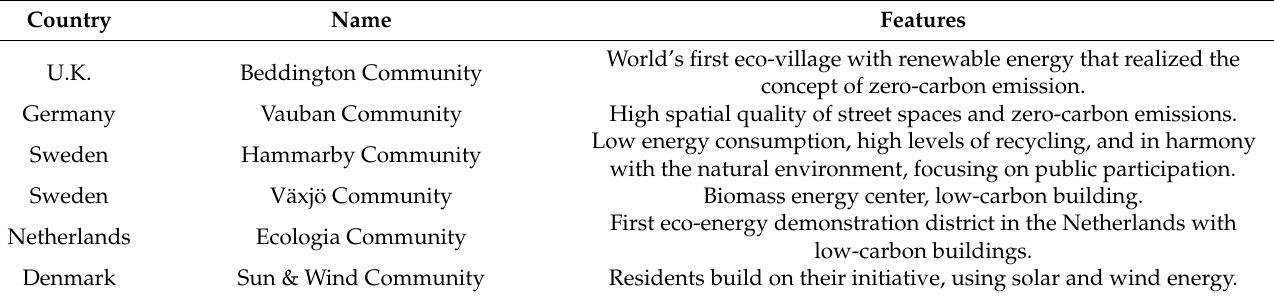
Table 2. Research of Existing LCC